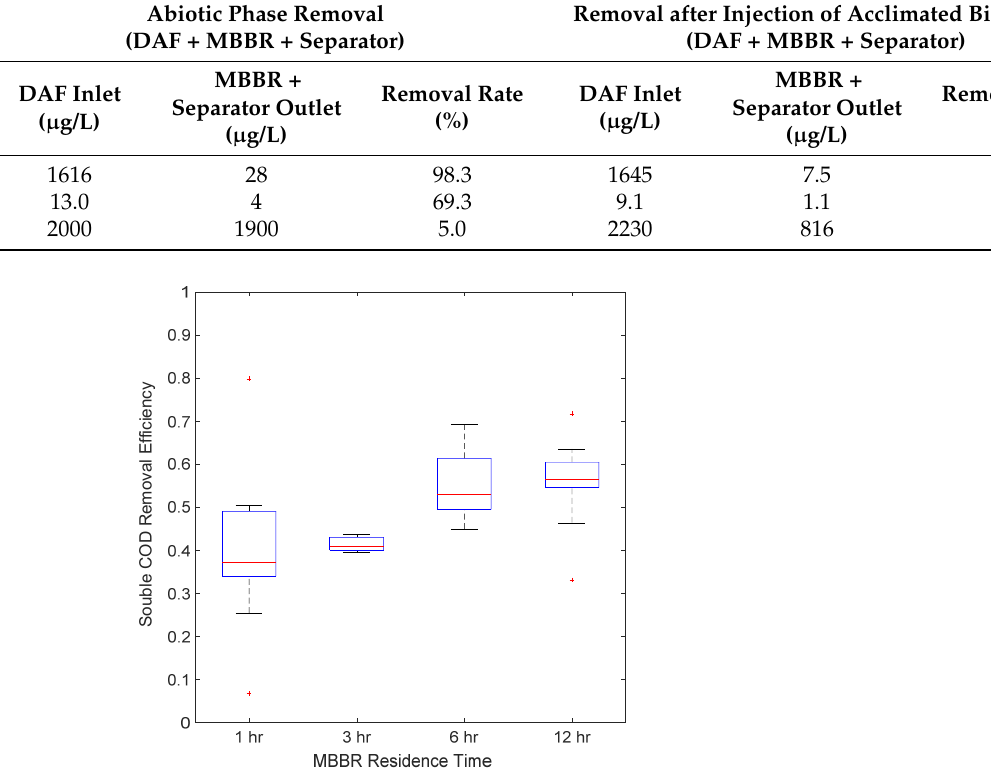
Figure 10. Average Soluble COD removal efficiency versus MBBR residence time.